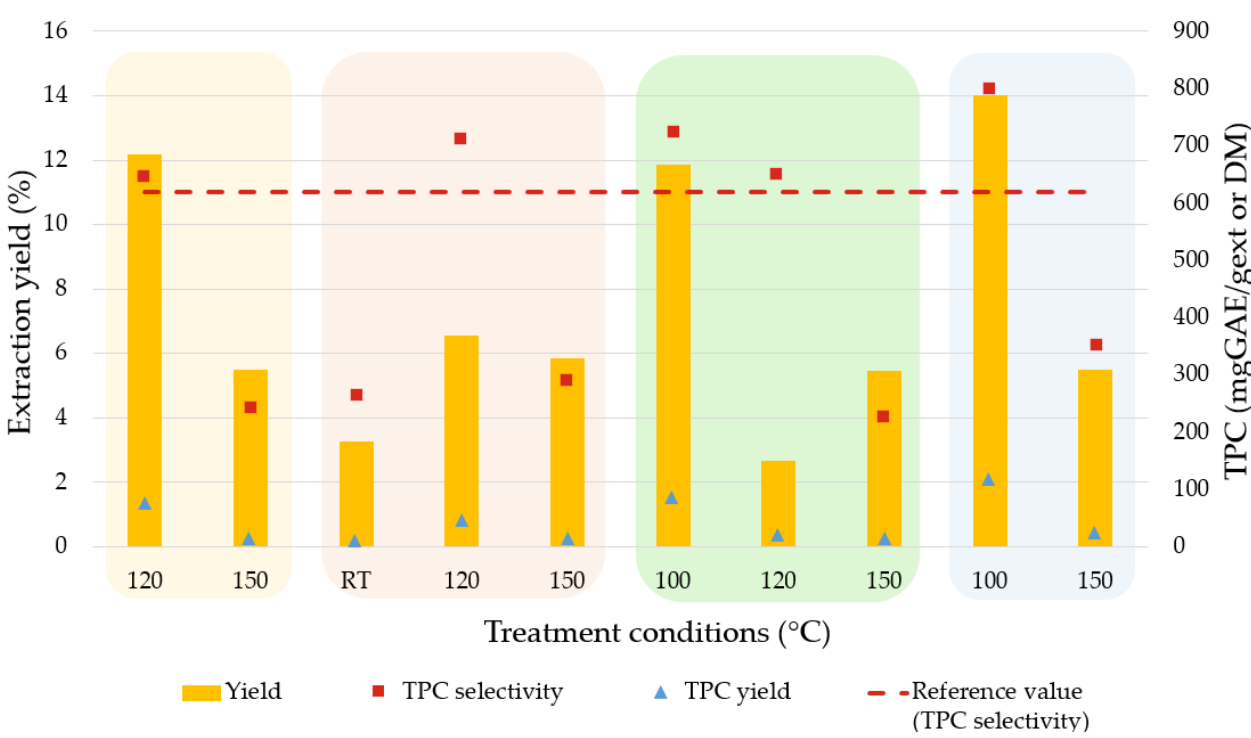
Figure 2. Extraction yield and TPC: comparison with the commercial benchmark (SilvaFEED ENC).